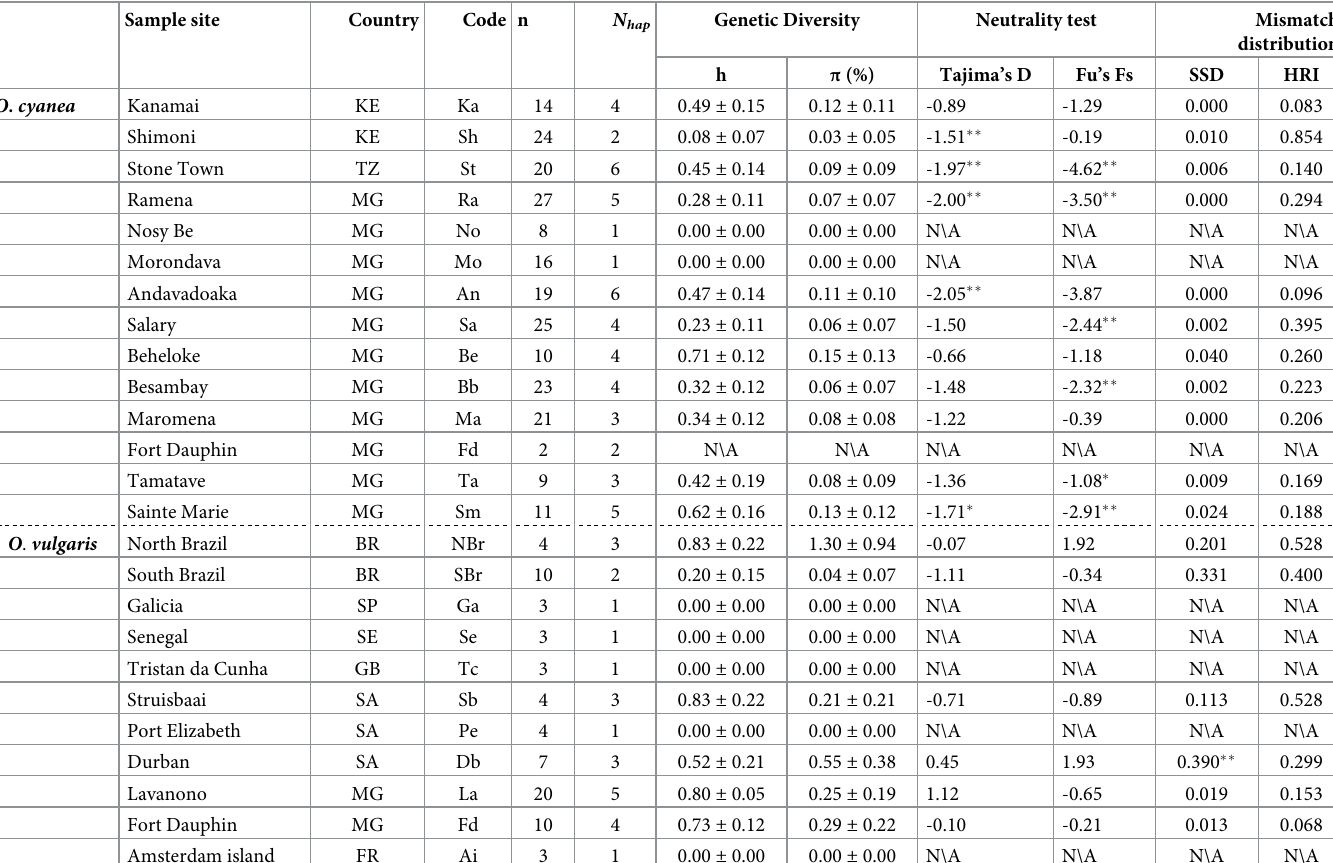
Table 1. Measures of genetic diversity, tests for neutrality and mismatch distributions for Octopus cyanea and O . vulgaris . Sample